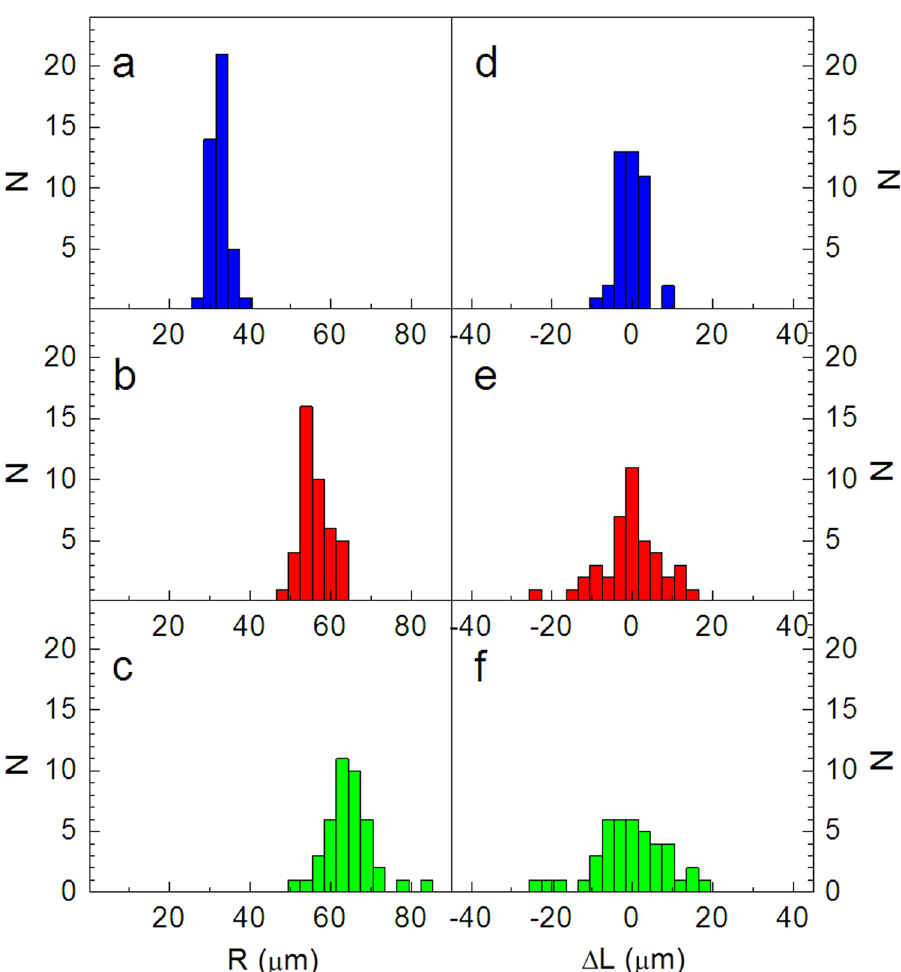
Figure 4. ( a – c ) Radial distributions N ( R ) of the droplet positions in the first (a), second (b) and third ( c ) coordination circles. ( d – f ) Azimuthal distributions N (Δ L ) of the droplet positions in the first ( d ), second ( e ) and third ( f ) coordination circles. The histograms are plotted using the spatial distribution of droplets in Fig.